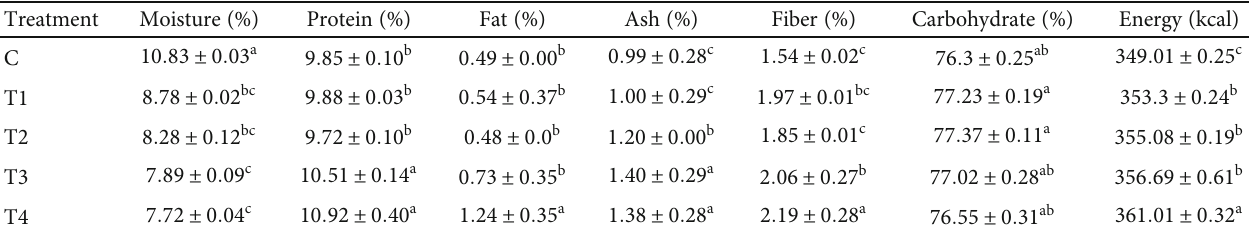
Table 2: E ff ect of blending ratio on proximate composition of wheat-moringa noodles.